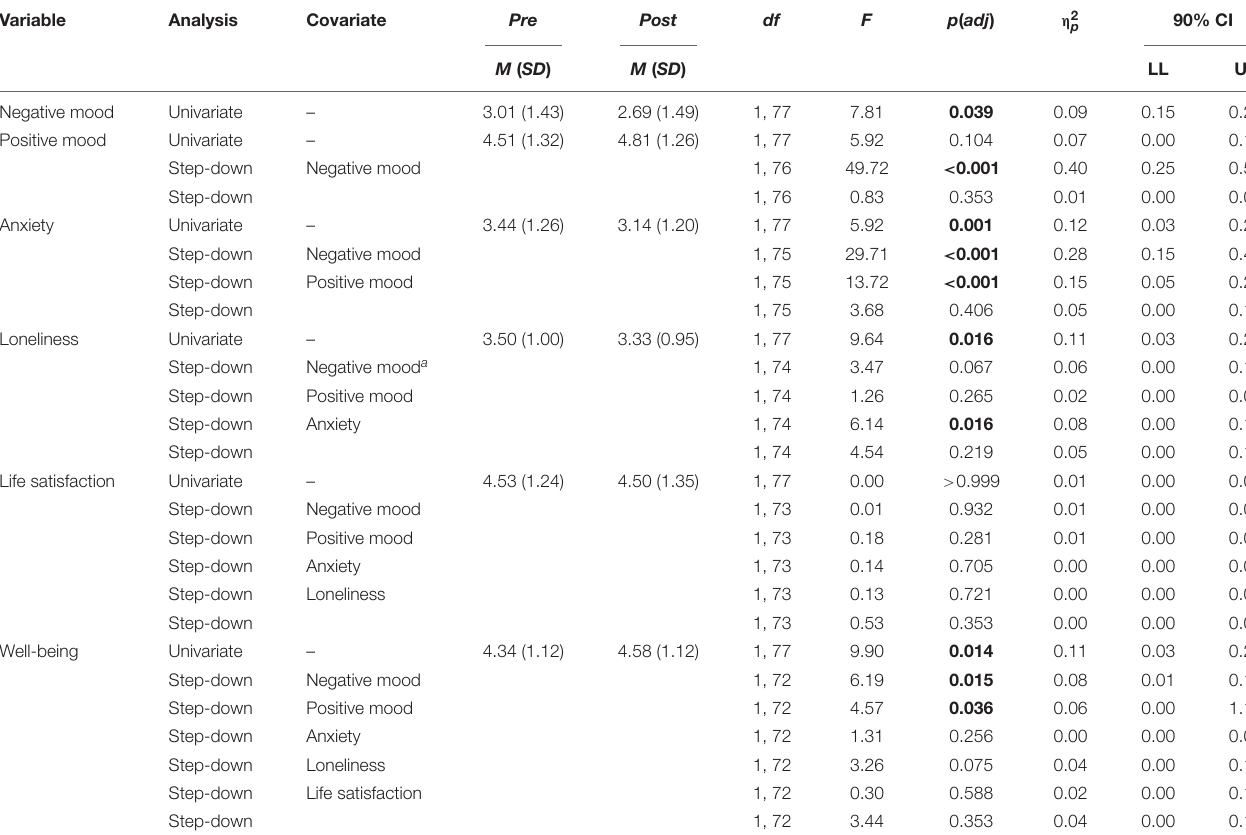
TABLE 2 | Stepdown analysis